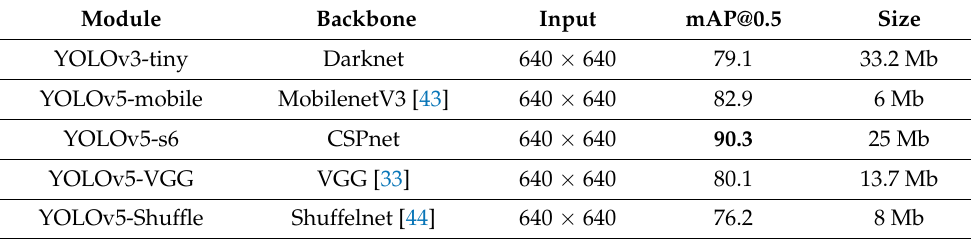
Table 5. A comparison between different backbones.